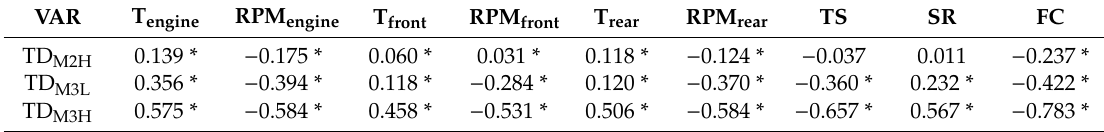
Table 15. Pearson correlation analysis results between tillage depth and mechanical load elements.